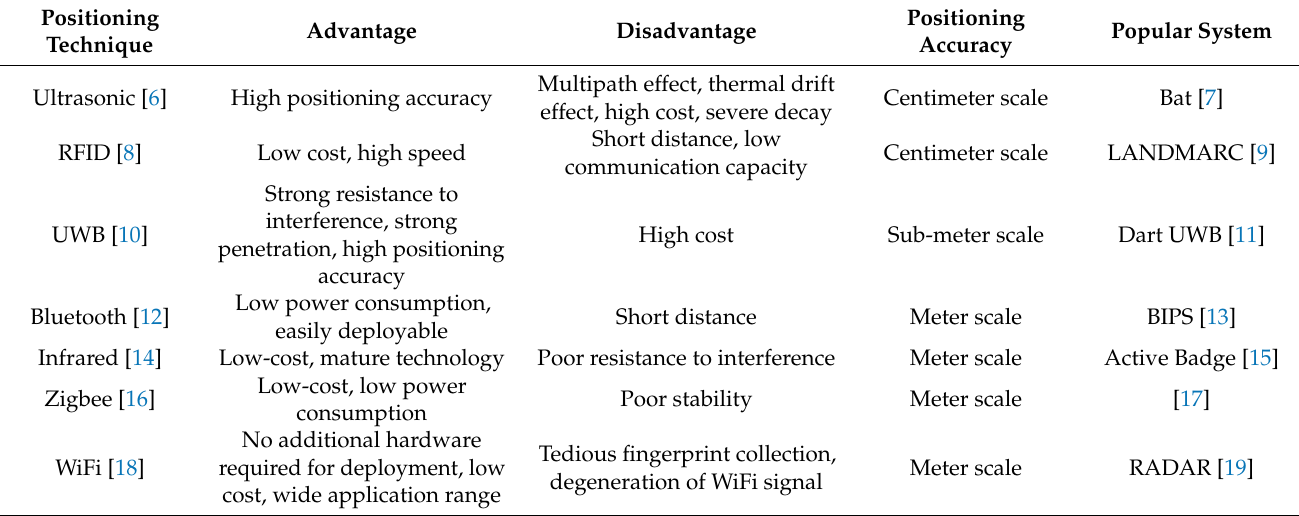
Table 1. Major indoor positioning